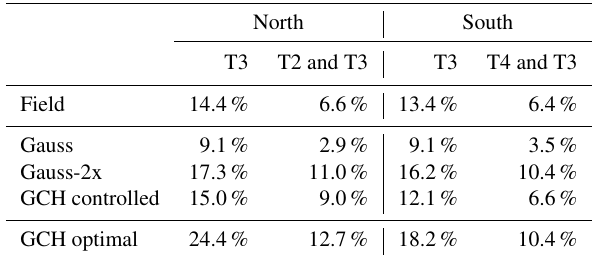
Table 2. Overall percent reduction in wake losses across the con- trolled